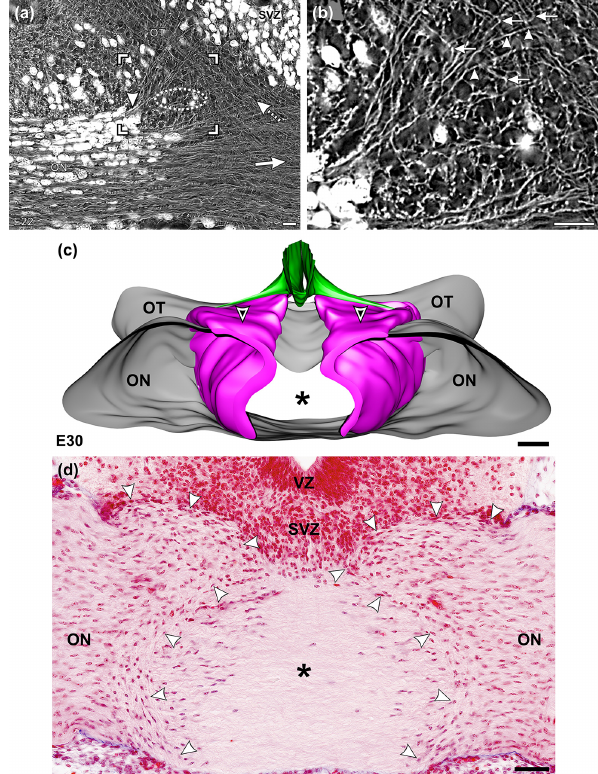
Figure 7. Glial arches deflect ipsilaterally projecting axons in the developing optic chiasm of Tupaia belangeri . (a, b) Embryonic day (E) 22: inverted gray-scale micrographs of a hematoxylin-eosin- stained horizontal section. (a) Leaving the optic nerve (ON), most axons project contralaterally (solid arrow), whereas ipsilaterally projecting axons (arrowhead) are deflected at the developing glial arch (dotted circle). Dotted arrow, crossing axons from the con- tralateral optic nerve; OT, optic tract; SVZ, subventricular zone. (b) Detail magnified from boxed area in (a) . Different from con- tralaterally projecting axons (arrowheads), ipsilaterally projecting axons are sharply deflected (arrows) lateral to the glial arch cell bodies. (c) E30: 3-D reconstruction. Glial arches (magenta) reside at the transition of the optic nerve and chiasm (gray). Green, SVZ of the third ventricle; arrowheads, position of the reconstructed Azan- stained coronal section shown in (d) , which demonstrates how cell bodies belonging to the glial arches “descend” (arrowheads) from the SVZ. Asterisk, chiasmatic midline; VZ, ventricular zone. Scale bars = 10µm in (a, b) ; 100µm in (c) ; 50µm in (d) . Reproduced from Knabe et al. (2008, Figs. 4, 11). © 2008 Wiley-Liss, Inc., by permission of John Wiley & Sons,